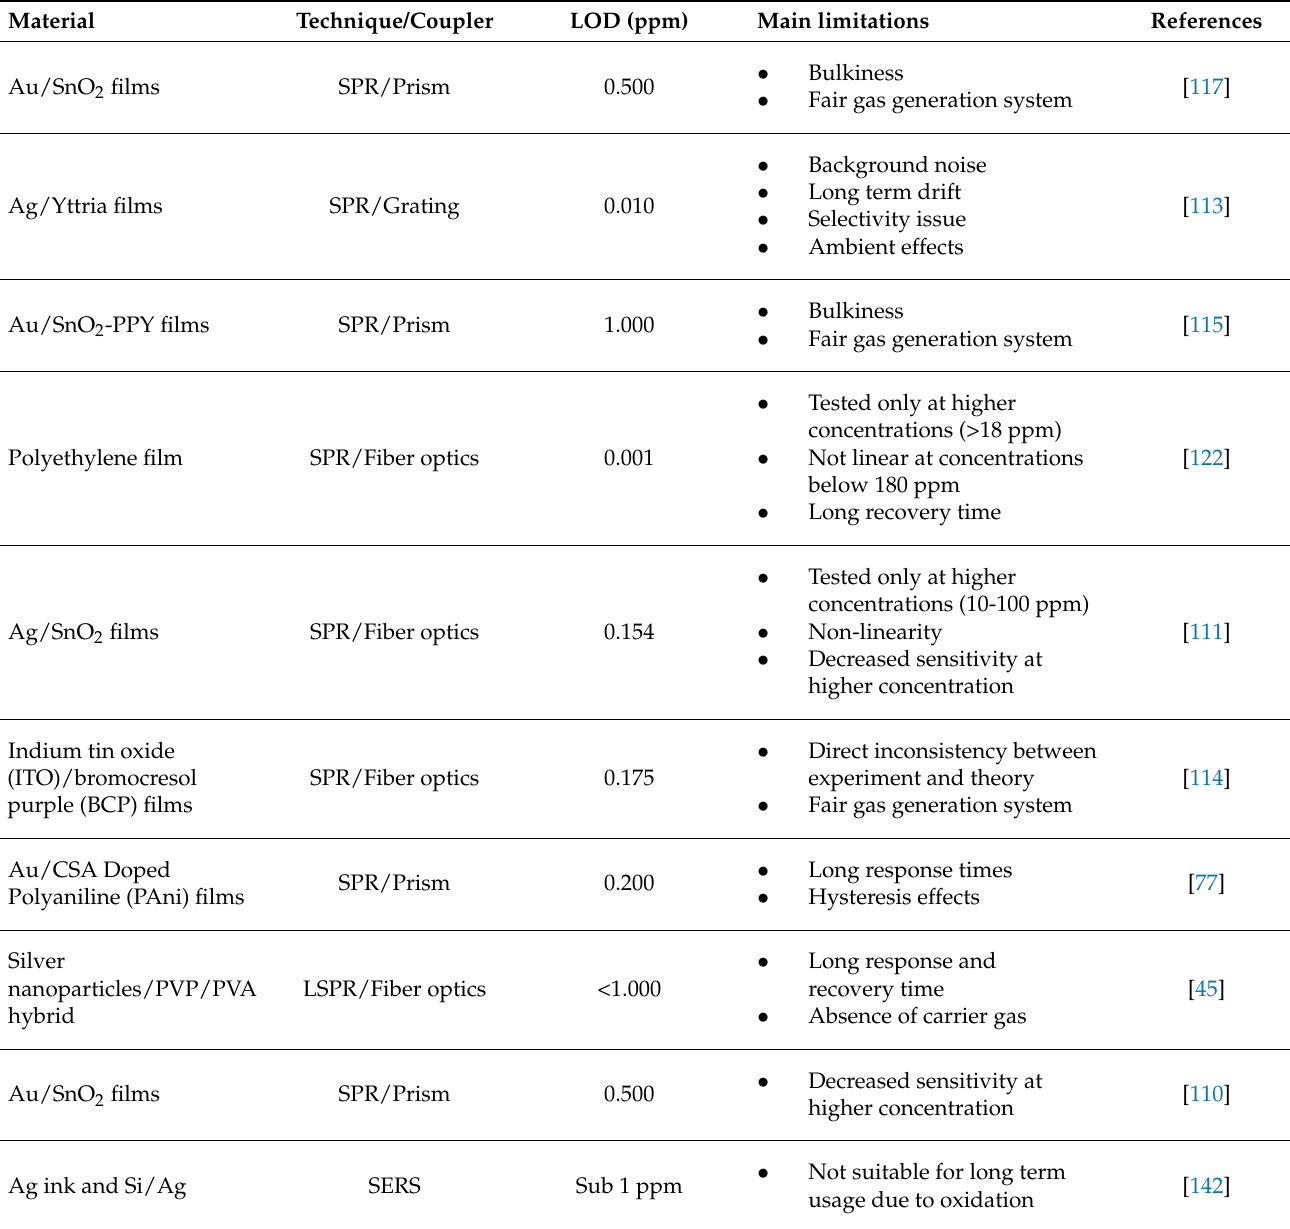
Table 1. Summary of plasmonic sensors for the detection of ammonia